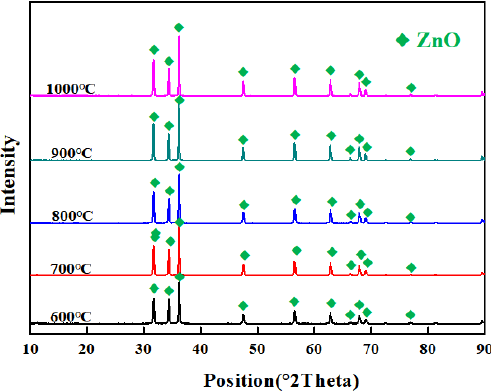
Figure 5. XRD pattern of zinc ash after dechlorination at different roasting temperatures.